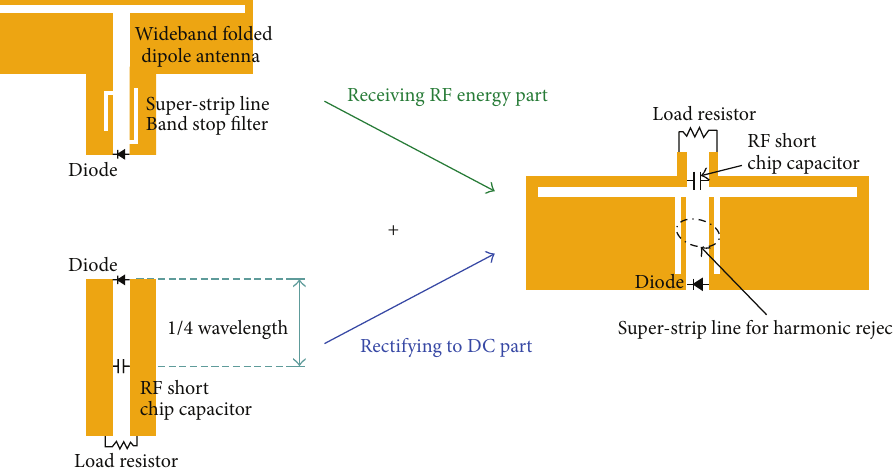
Figure 4: Schematic of combination to a novel compact topology rectenna.